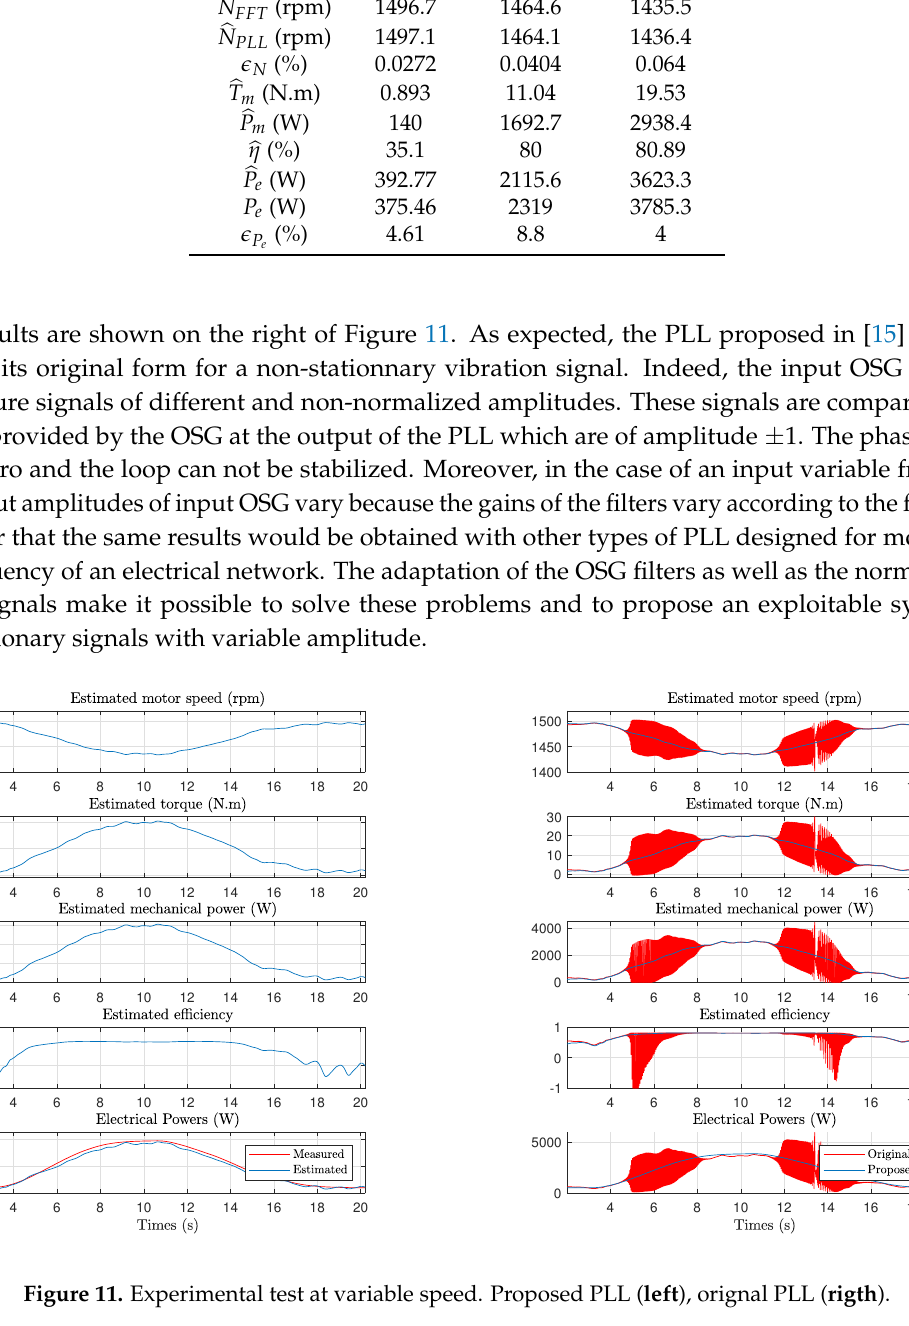
Figure 11. Experimental test at variable speed. Proposed PLL ( left ), orignal PLL ( rigth